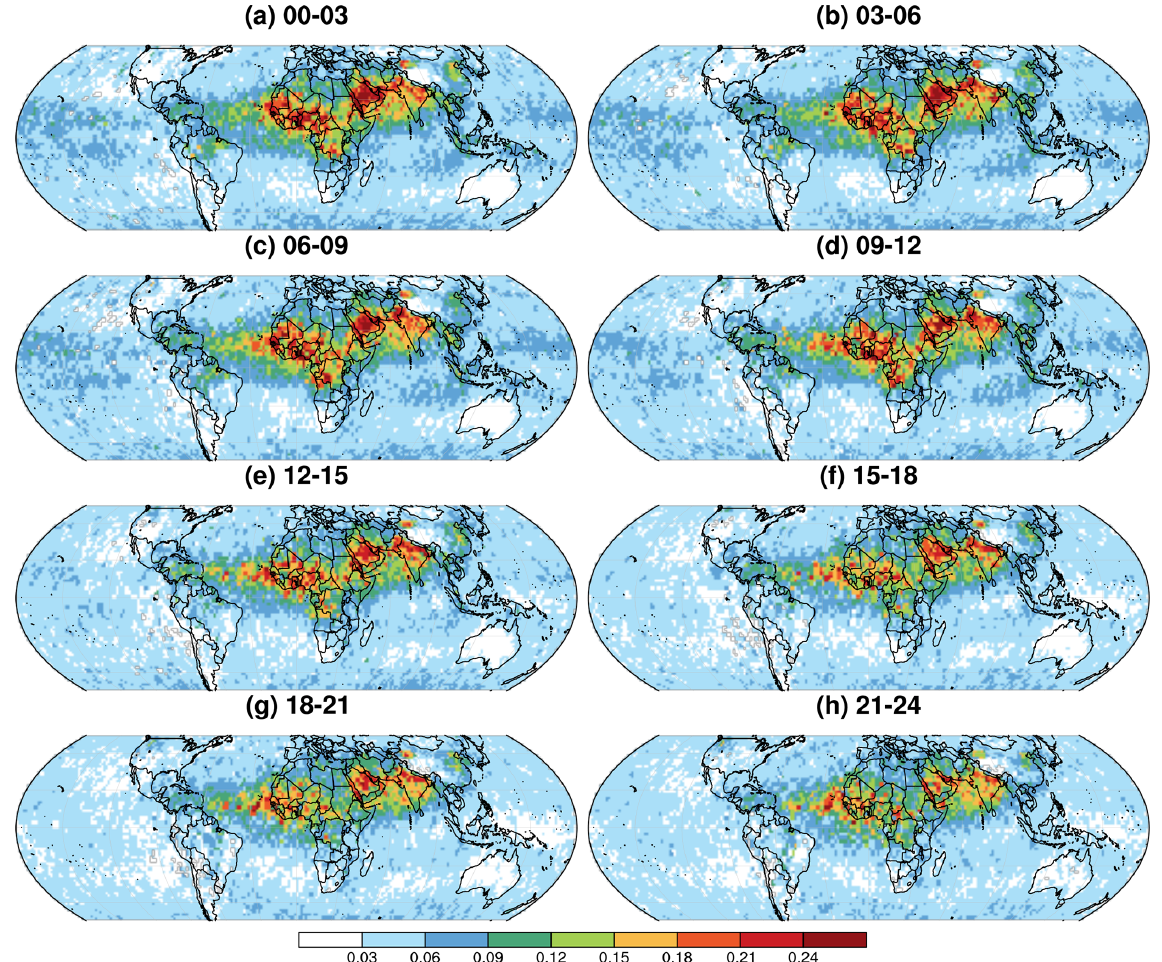
Figure 3. Annual-average DAOD from CATS during 2015–2017 in each 3h local time window: (a) 00:00–03:00, (b) 03:00–06:00, (c) 06:00– 09:00, (d) 09:00–12:00, (e) 12:00–15:00, (f) 15:00–18:00, (g) 18:00–21:00, and (h)